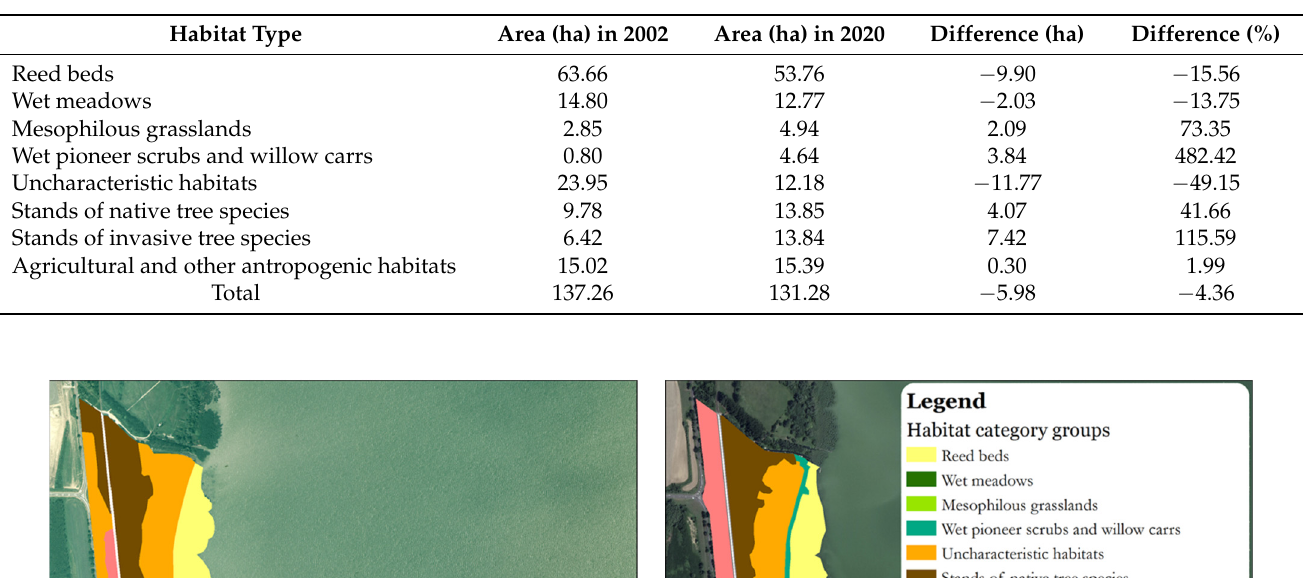
Table 1. Area changes of the habitat type categories between 2002 and 2020.